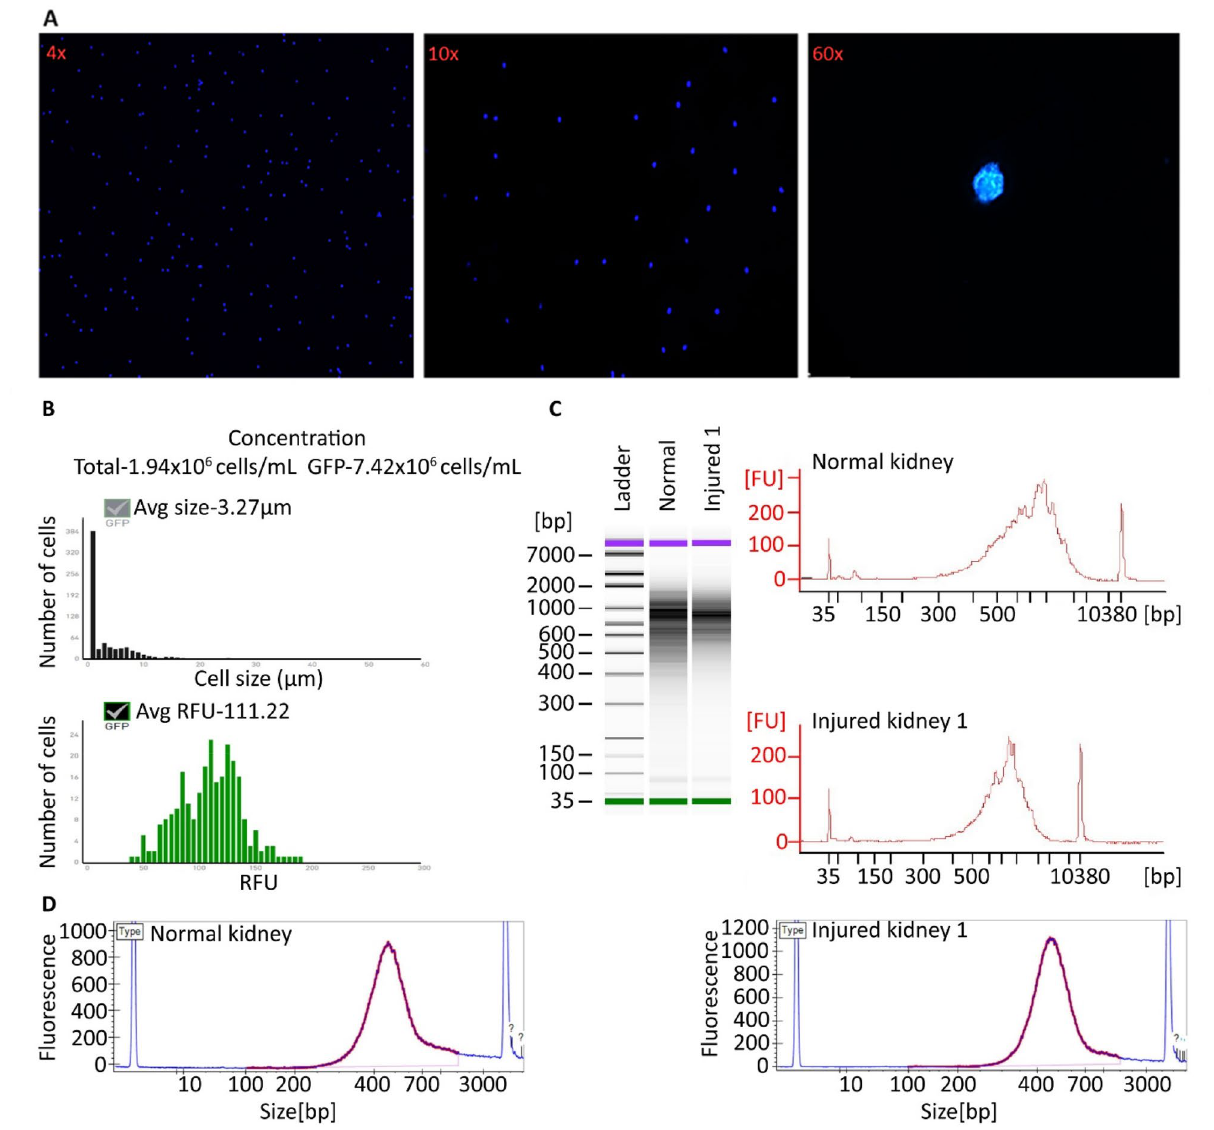
Figure 2. Quality control assessment of nuclei isolation from human kidney biopsies. ( A ) Representative images for morphological analysis of DAPI-stained nuclei. Magnification is in increasing order. ( B ) Cell number acquired by Countess II automated cell counter represents the total number of nuclei (GFP) and background noise (cellular debris, total). ( C ) Agilent bioanalyzer analysis of the cDNA traces. Fragments are expected to be > 600 bp with a max length of 2000 bp. Top, normal sample; bottom, injured kidney 1 sample. ( D ) Agilent bioanalyzer of post-library preparation quality. A size range of 400–600 bp is electronic cell counter (Fig. 2B). To show the applicability, feasibility, and reproducibility of the method, the protocol was repeated using needle biopsies collected from various mouse tissues without proceeding through the 10× Chromium Controller platform. Specifically, to evaluate the performance of the method independently of tissue type, multiple tissues from mice were used for nuclei isolation. Nuclei counts and integrity were consist- ent with human kidney isolations (Fig. 3). Fluorescent staining also confirmed that nuclei were indeed viable at the end of the protocol with little cellular membrane contamination. Depending on the number of samples and sample complexity, this procedure can be completed in 90 min or less for immediate processing through the 10× Chromium Controller platform. Isolated nuclei from human kidney biopsies were further examined. The manufacturer’s protocol for nuclei lysis and cDNA generation (10× Genomics: user guide CG000331, Rev C) was followed as recommended. On average, 2483 (N = 13,075 total) nuclei were isolated across normal and acute injury (Supplementary Table 1). Quality control metrics verified the isolation of high-quality nuclei. Bioanalyzer analysis of cDNA traces pre- library (Fig. 2C) and post-library (Fig. 2D) preparation yielded the expected fragment size and peaks. A range of 1–48 ng of total cDNA was used to generate libraries (Supplementary Table 1). An input of 1 ng is the lowest concentration suggested by 10× Genomics, producing high library quality without traces of degradation (Fig. 2D).